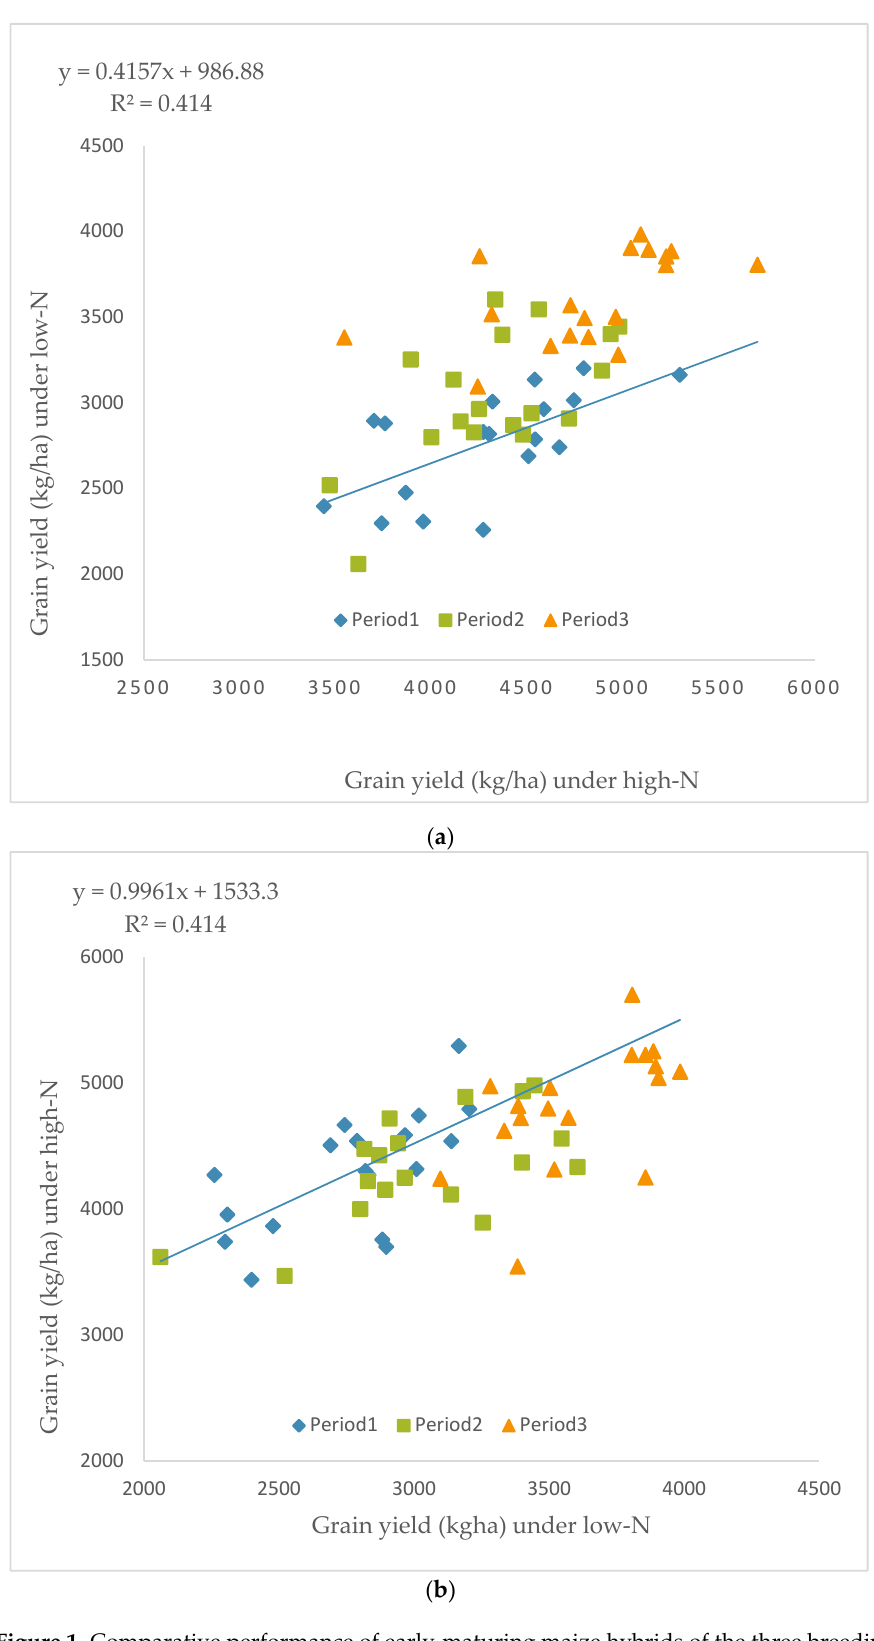
Figure 1. Comparative performance of early-maturing maize hybrids of the three breeding periods in low and high N environments. Regression of ( a ) grain yield of low N on grain yield of high N and ( b ) grain yield of high N on grain yield of low N